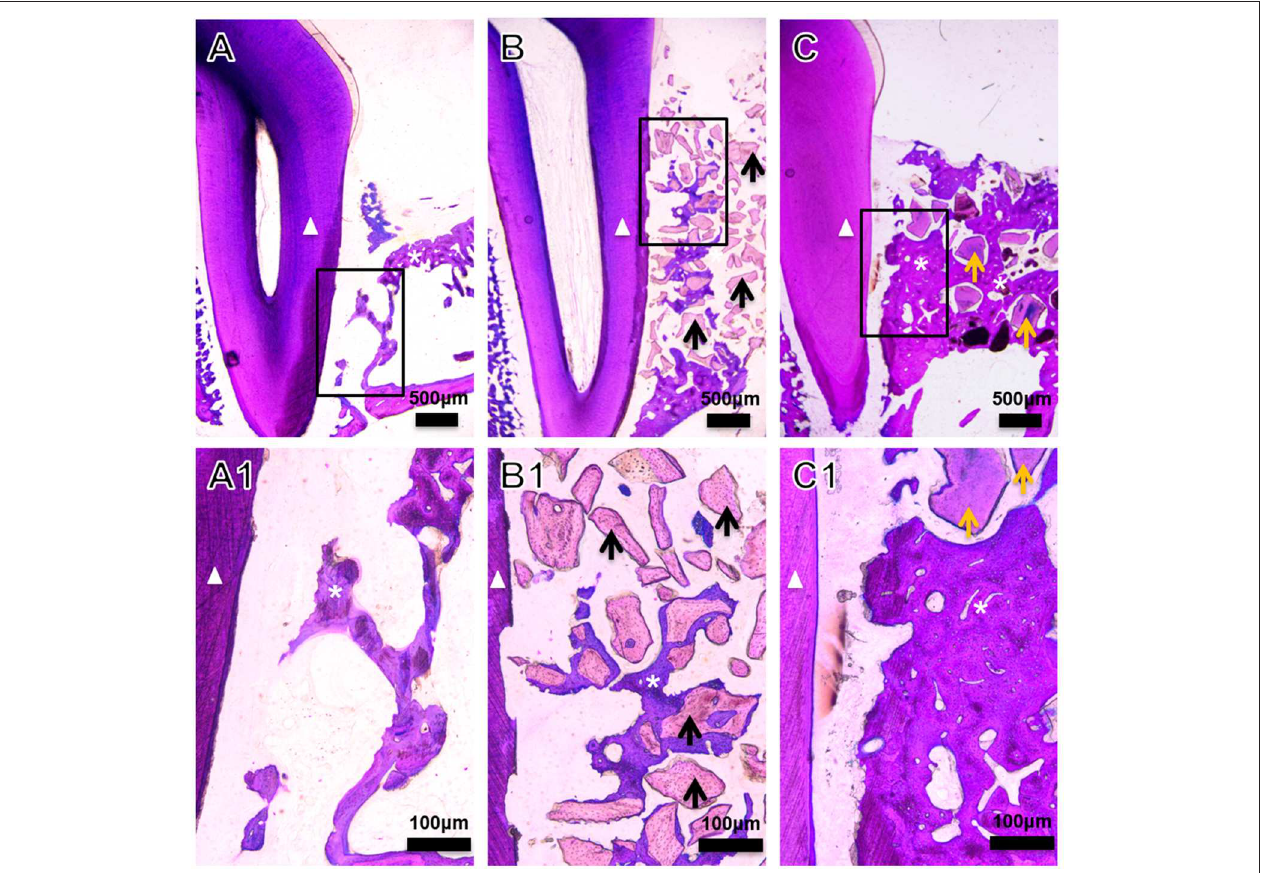
FIGURE 1 | Representative histological images of the bone defect slices from (A) Control, (B) DBB, and (C) BioCaP group at week 8. (A1–C1) are high-resolution images of (A–C) , respectively. White triangle, dental root; asterisk, newly formed bone; black arrow, DBB; yellow arrow,